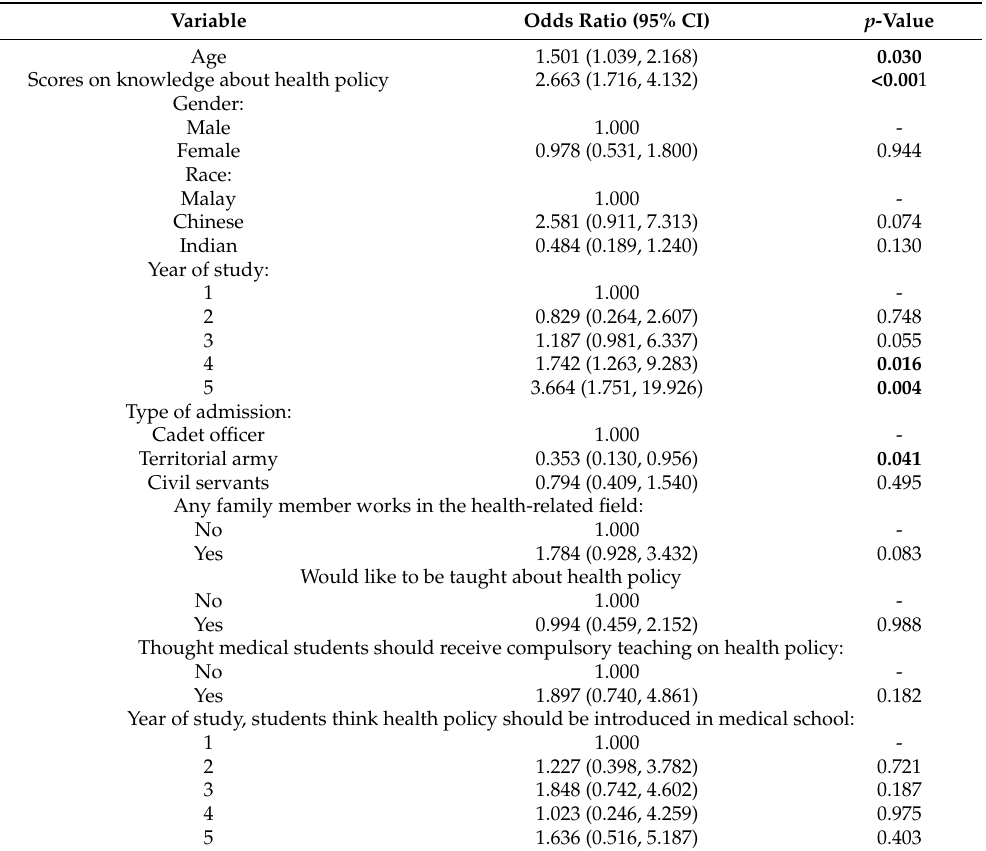
Table 4. Simple logistic regression of factors associated with the student’s involvement in health policy roles ( n =